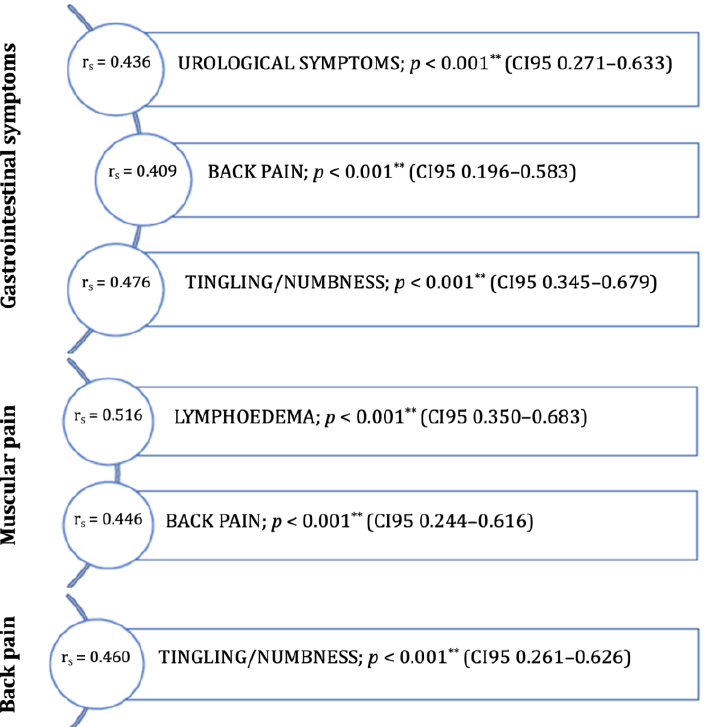
Figure 1. Moderate symptom correlations (r s = 0.40–0.69) in women (post-treatment of endometrial cancer). ** p < 0.001.